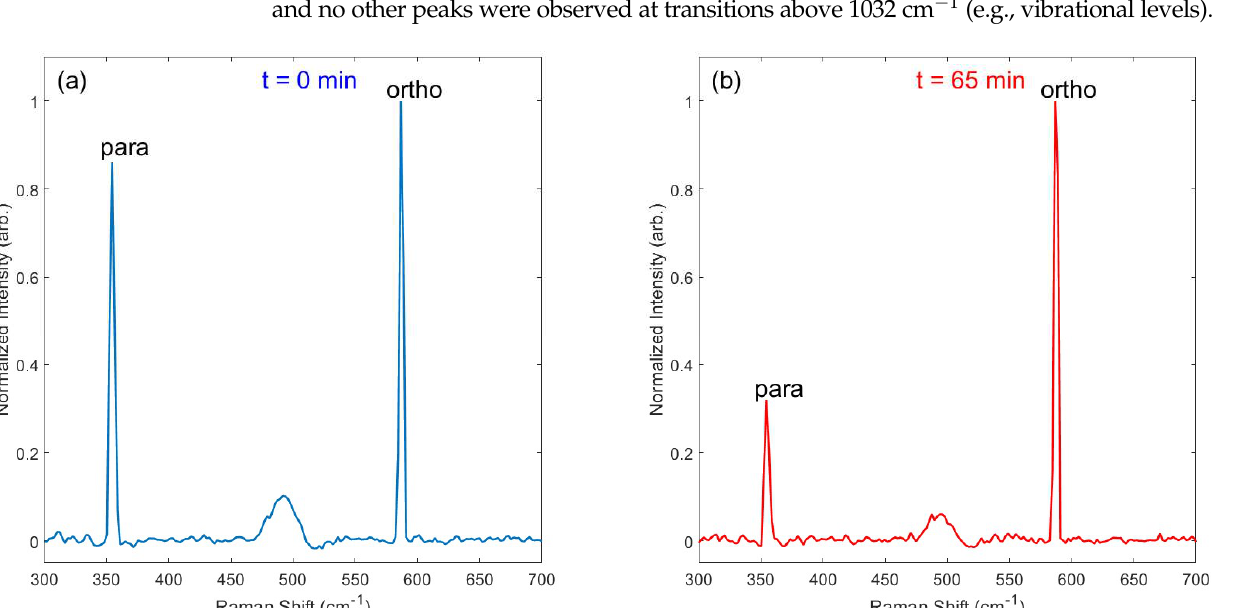
Figure 5. Plot comparing the ratio of integrals for the 586 cm −1 peak ( ortho ) vs. the 355 cm −1 peak ( para ) over time in a valved NMR tube coated with APTES. The initial 1-to-1 ratio denotes a 50/50 mixture of para and ortho spins, which slowly equilibrates to a 1-to-3 ratio of para vs. ortho upon reconversion.